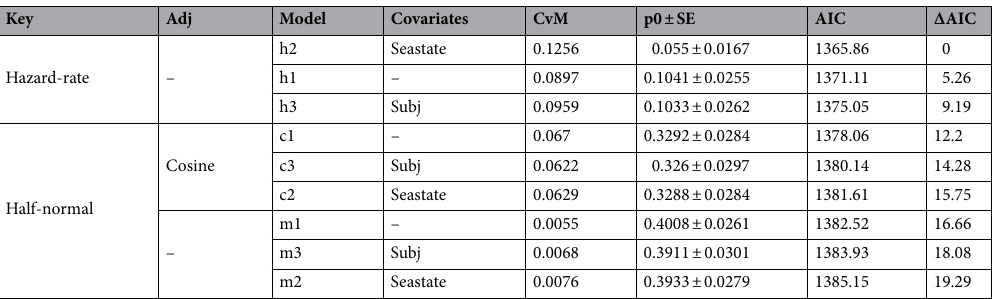
Table 2. Detection functions tested. Key: key function used for the detection function model; adj: adjustment series for the function (if any); model: model name as referred to in the text; covariates: the covariates used (in addition to distance to the transect line); CvM: Cramér van Mises p-value for goodness of fit; p0: estimated average detectability of animals on the transect line (including standard error); AIC: Akaike information criterion; ΔAIC: difference in AIC (compared to model with lowest AIC).